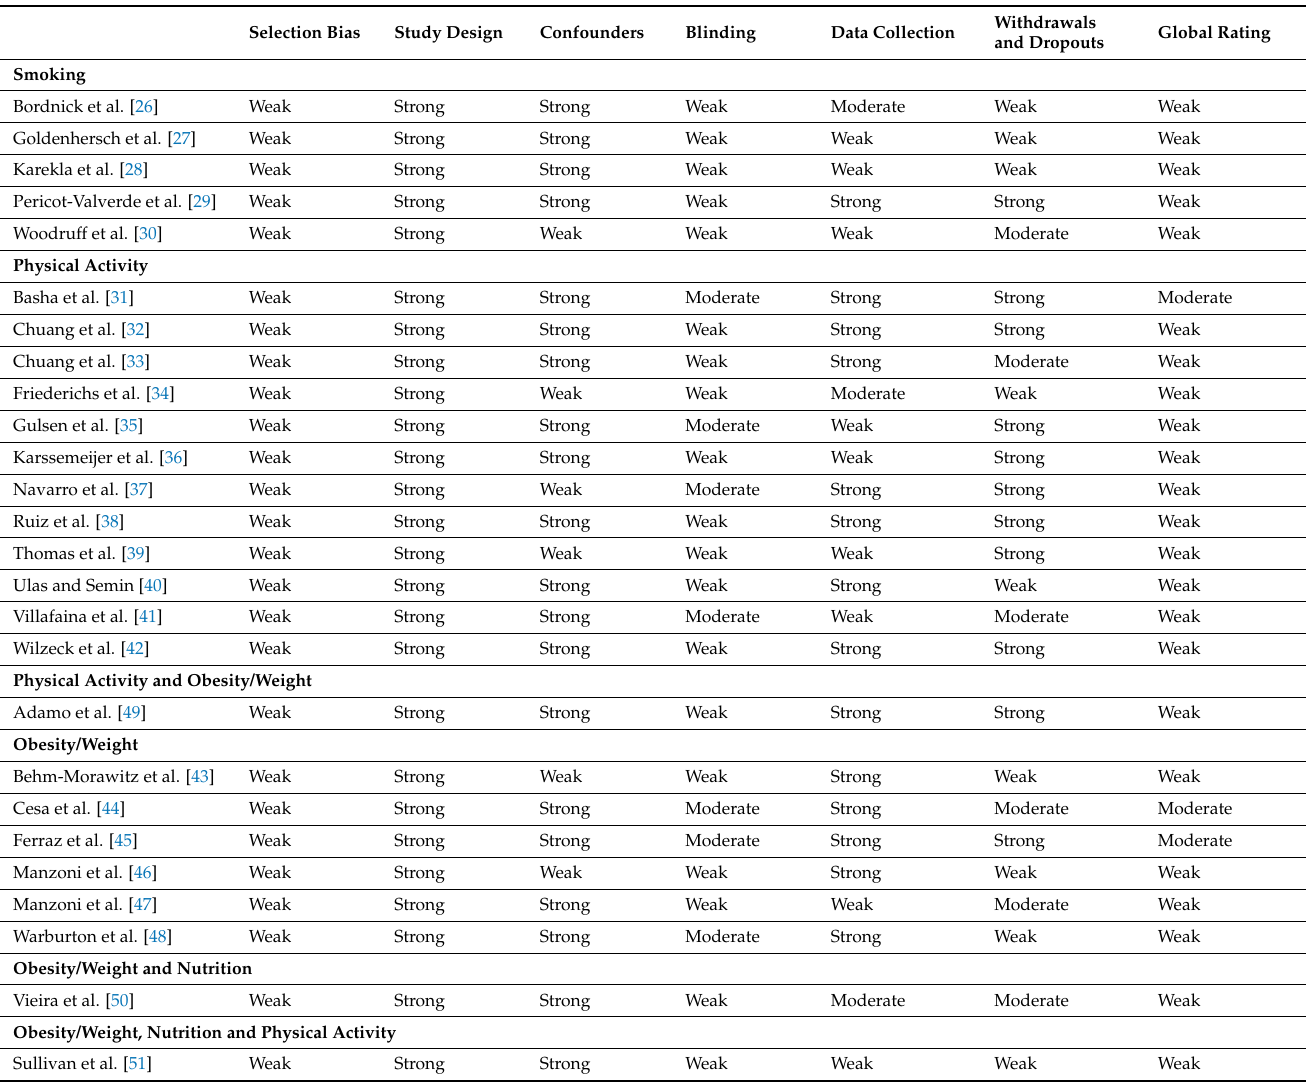
Table 1. Quality assessment of included